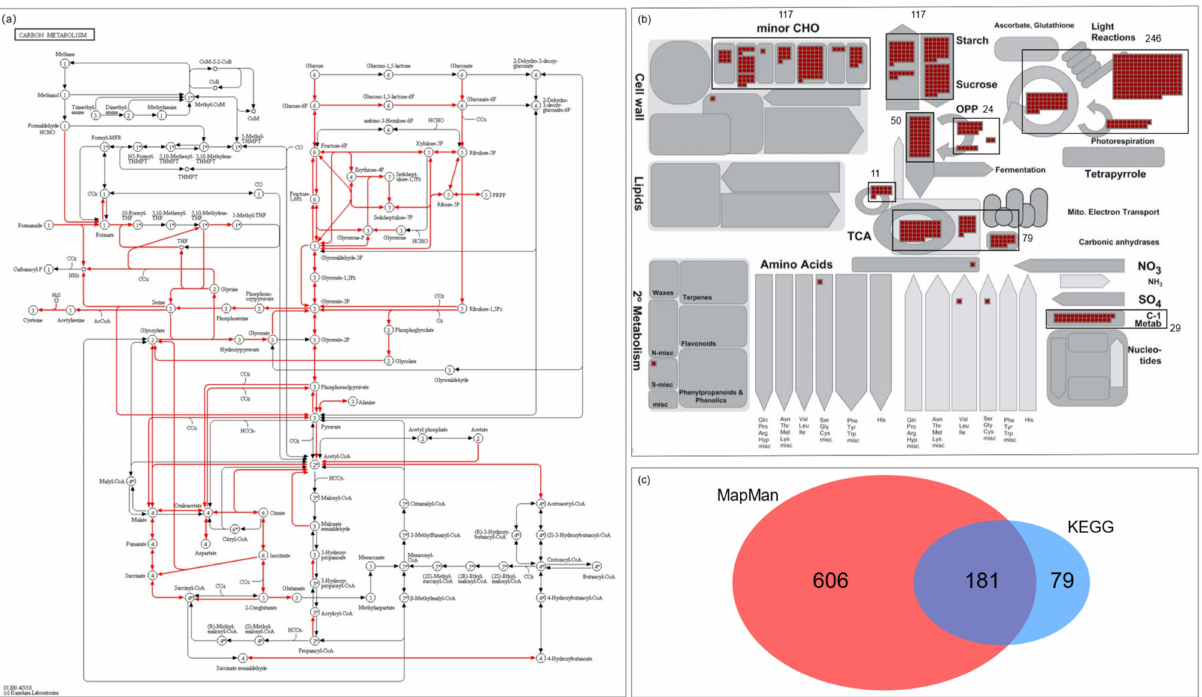
Figure 1. Schematic diagram summarizing 866 carbohydrate metabolism-related genes retrieved from the KEGG database and the MapMan toolkit. In the KEGG database, carbon metabolism pathway genes were selected and applied to the MapMan toolkit to find associated MapMan annotations. ( a ) There were eight bincodes related to 266 KEGG genes and with multiple members. ( b ) The bins with a black box and the total number of whole elements in each bin were indicated. Therefore, 681 MapMan genes associated with carbohydrate metabolism were selected. In addition, 106 carbohydrate transporters annotated in MapMan were included. A total of 787 genes from the MapMan toolkit and 266 from the KEGG database were collected. ( c ) Finally, 872 carbohydrate metabolism-related genes were collected. For further analysis, 866 genes with RGAP locus information were used. The detailed information of the 866 genes, including 181 overlapped genes, is listed in Table